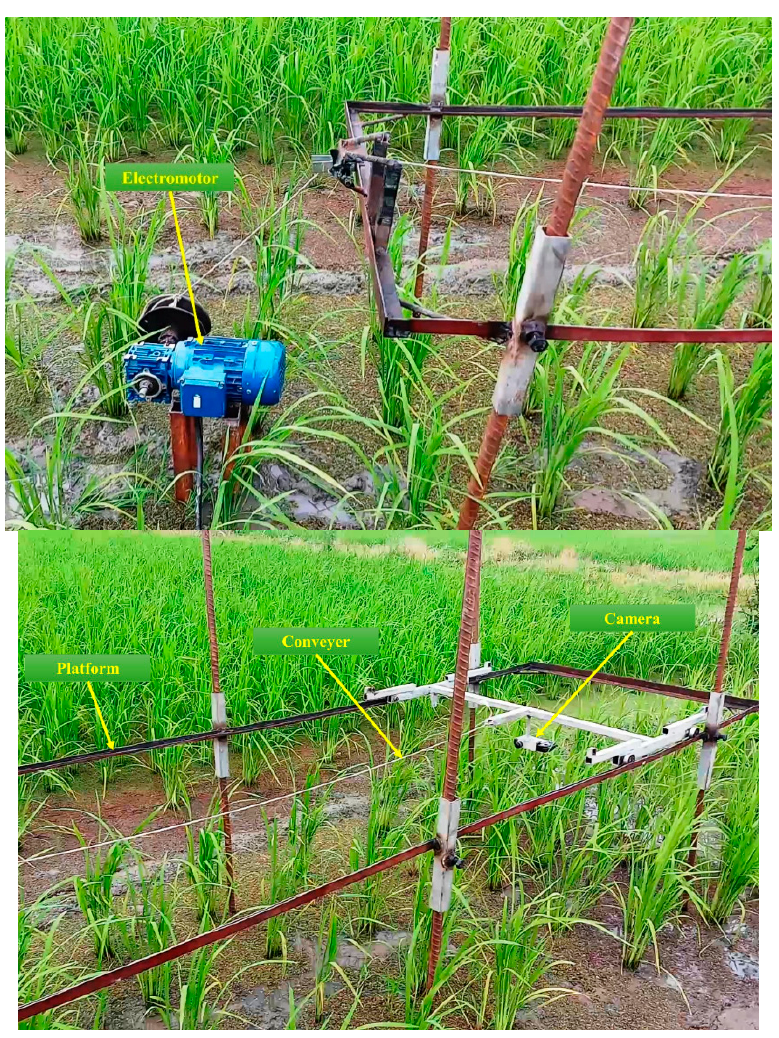
Figure 1. A rail platform for holding the camera and moving it across the field: 3 m length. Note: The growth stage of the rice on the BBCH scale was leaf development and tillering (from 1 week after transplanting to the sixth week) and weeds were leaf development (after three leaves unfolded). Water depth was 10